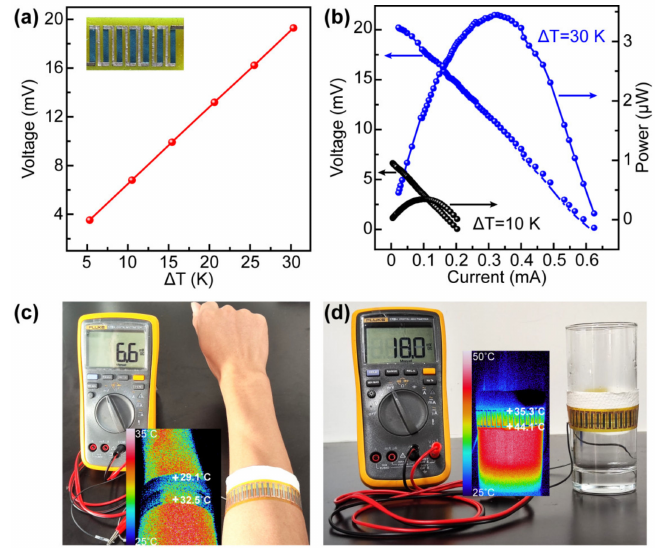
Figure 5. The output performance of the seven-leg TE device fabricated with the S3 CP+HP 2 film on the PI substrate. ( a ) The relationship between the open-circuit voltage and temperature difference (the inset is a digital photo of the seven-leg TE device). ( b ) The output voltage and power versus current at ∆ T of 10 K and 30 K. ( c ) A digital photo of 6.6 mV voltage created from the ∆ T between the arm and the ambient (the inset is the corresponding infrared thermal image of the twenty-three-leg TE device). ( d ) A photo of 18 mV voltage created by the ∆ T between the upper (cold) and lower (hot) surface of a beaker (the inset is the corresponding infrared thermal image of the twenty-three-leg TE device).